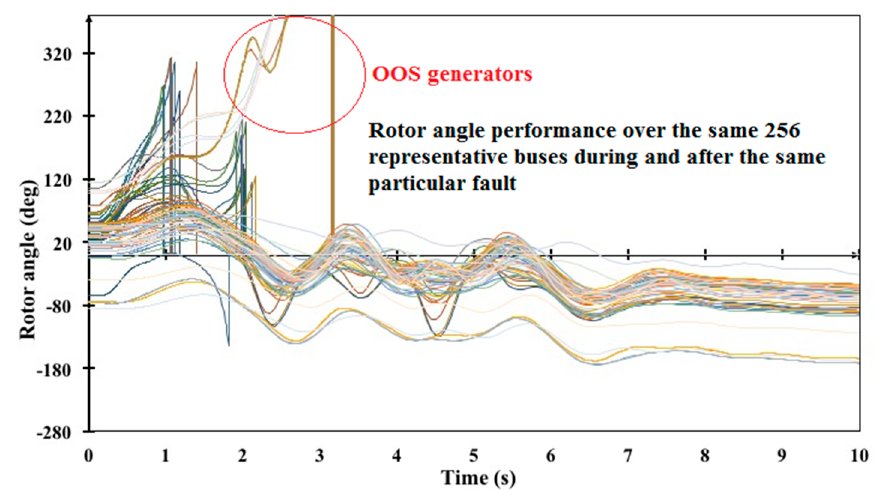
Figure 9. System separation for dispatch SLL 2 .